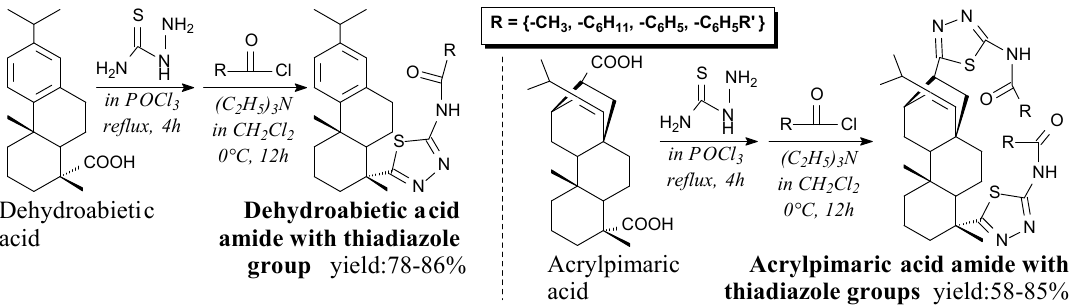
Scheme 40. Synthesis of rosin acid amides with thiadiazole